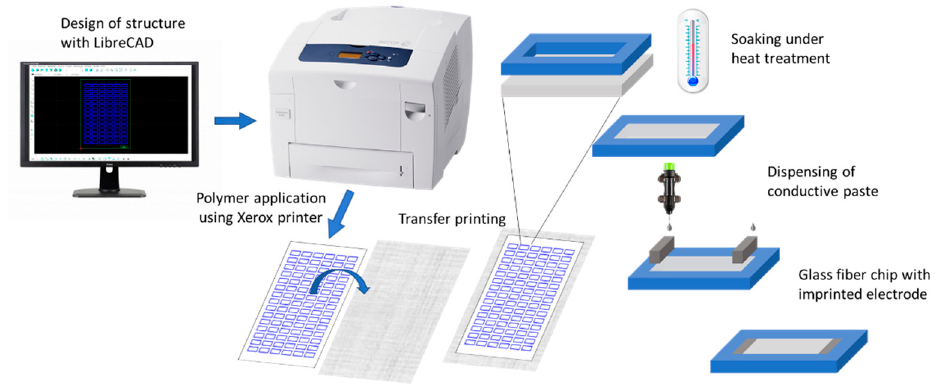
Figure 1. Schematic illustration of the transfer printing process of the glass microfiber. The pattern was generated via LibreCAD and printed on overhead film via a Xerox wax printer. Induced by heat application, the wax was transferred to the underlying fiber material. As electrodes within the fiber channel, a conductive carbon paste was applied using a dispenser.